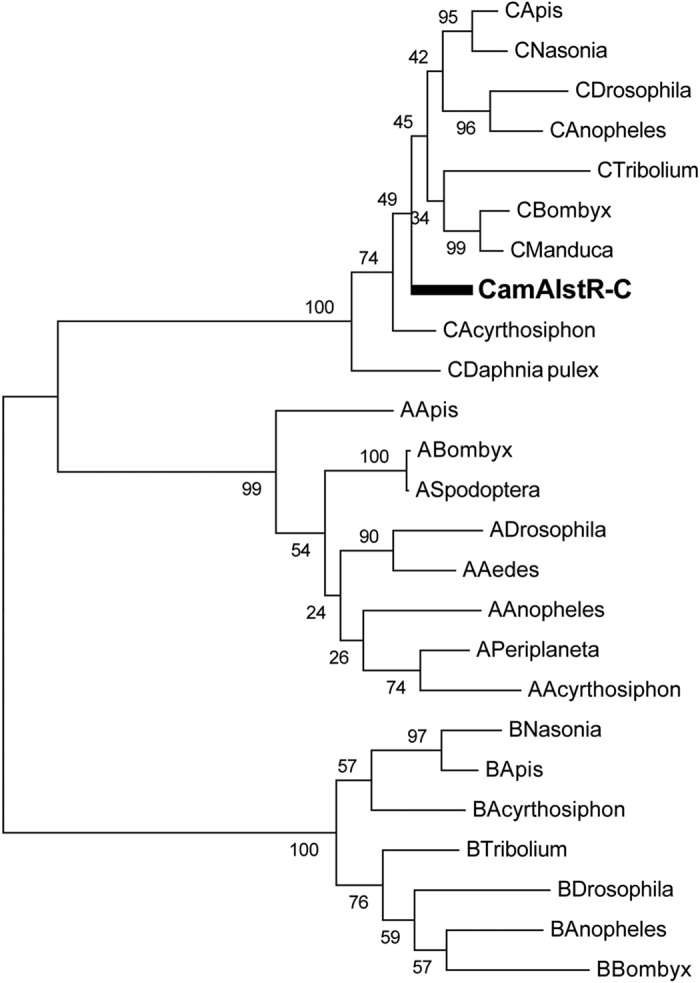
Phylogenetic analysis of AlstR identified in Carausius morosus.The evolutionary analysis of CamAlstR-C was inferred by using the Maximum Likelihood method in MEGA5. The letters (A,B and C) before the genus names correspond to the types of receptors. Ex; CDrosophila: AlstR type C of Drosophila genus. The branch in bold represents type C AlstR of C. morosus.